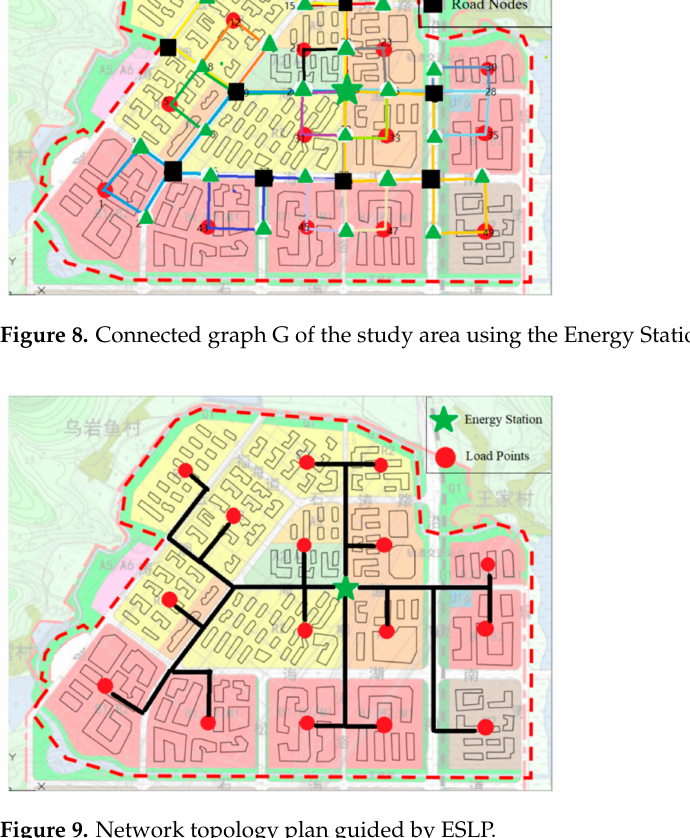
Figure 9. Network topology plan guided by